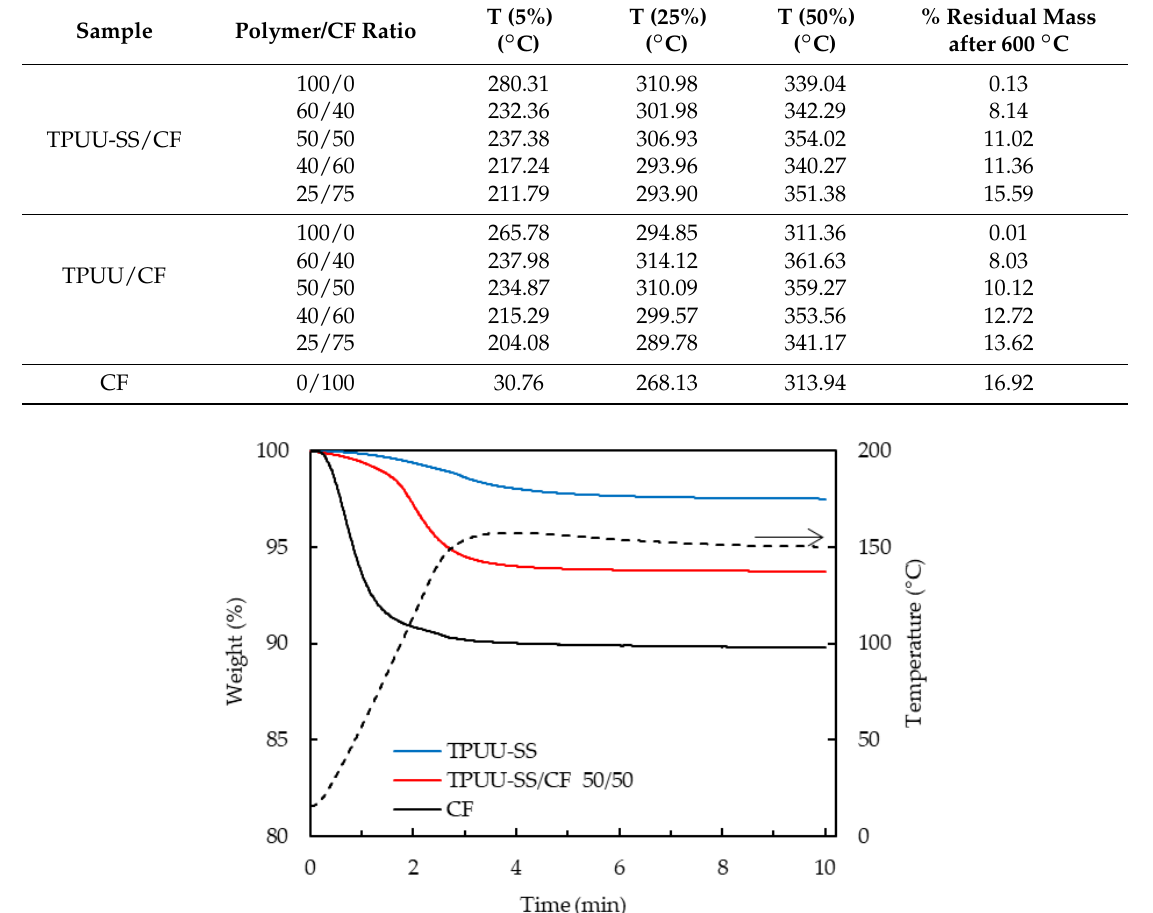
Figure 5. TGA isothermal curves of CF, TPUU-SS/CF (50/50) and TPUU-SS.